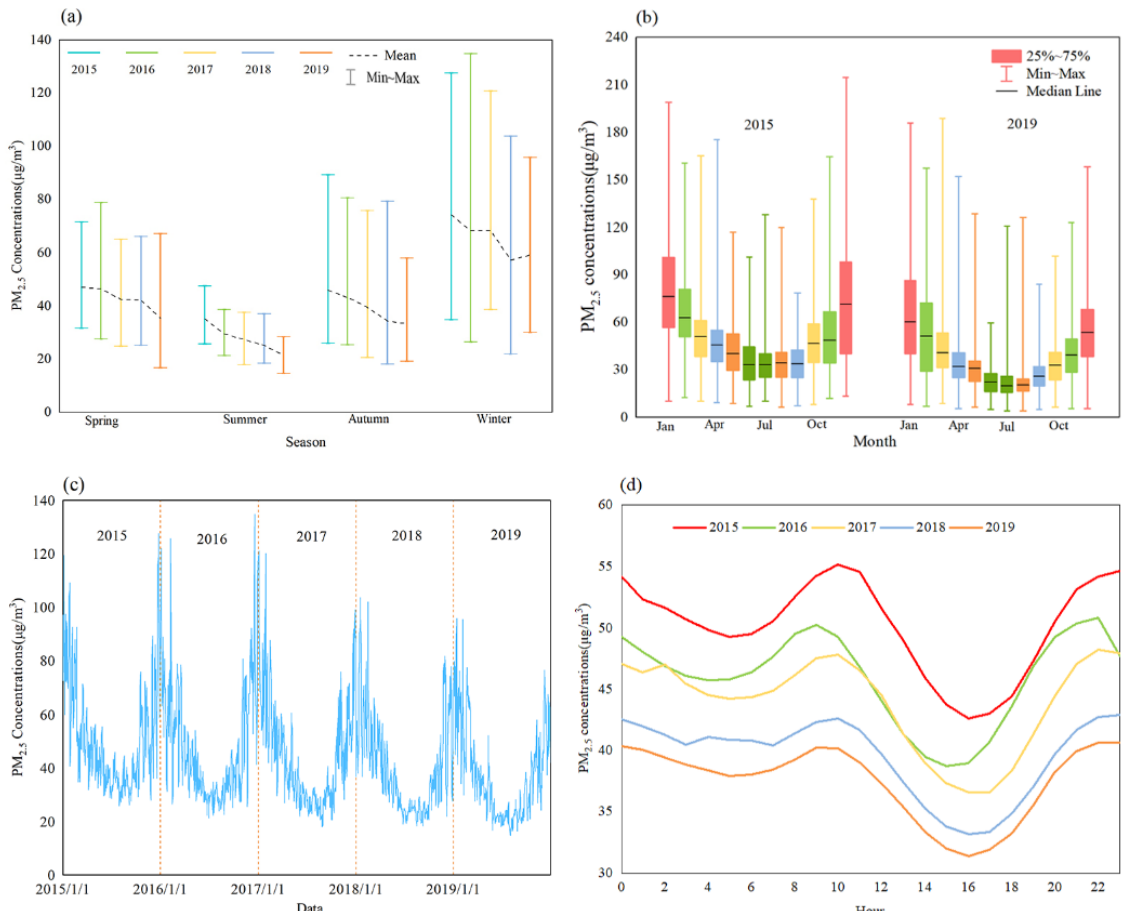
Figure 1. Temporal changes of PM 2.5 in China between 2015 and 2019. ( a ): Seasonal change; ( b ): Monthly change; ( c ): Daily change; ( d ): Hourly change.